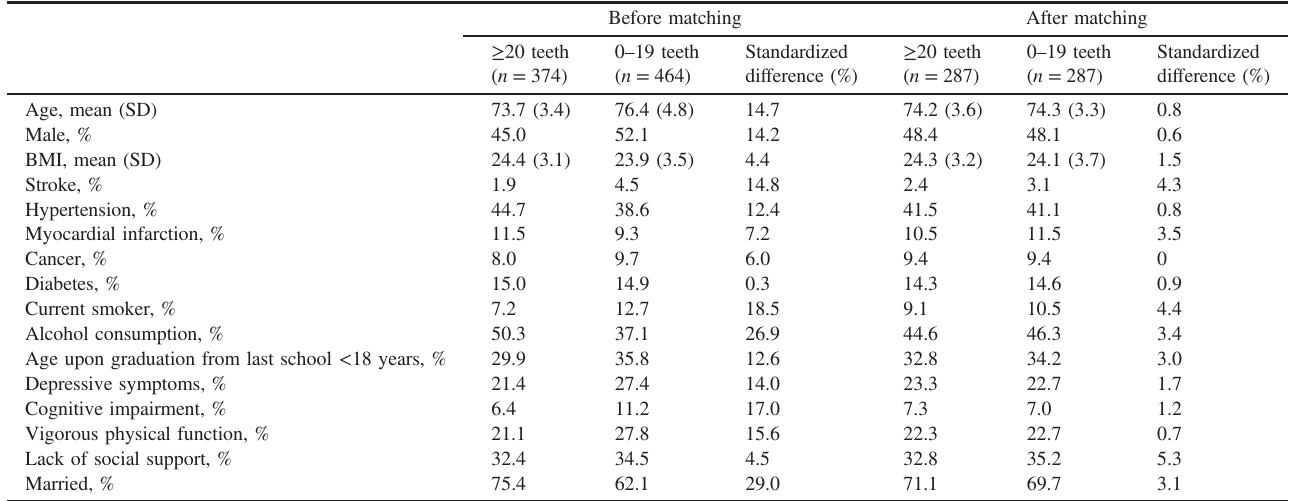
Table 1. Baseline characteristics before and after propensity score matching according to the number of remaining teeth Before matching After matching